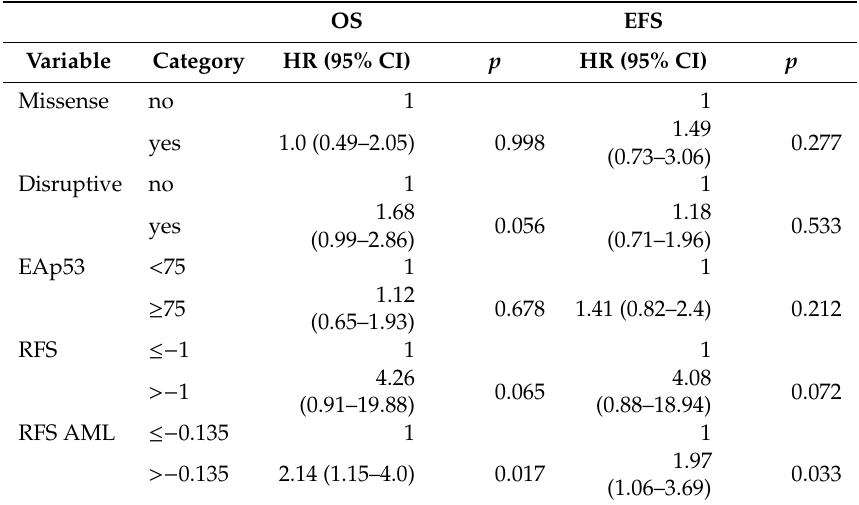
Table 3. Multivariable Cox proportional hazards regression analysis of the e ff ect of di ff erent functional mutation scoring systems on overall survival (OS) and event-free survival (EFS) in patients with TP53 -mutated acute myeloid leukemia